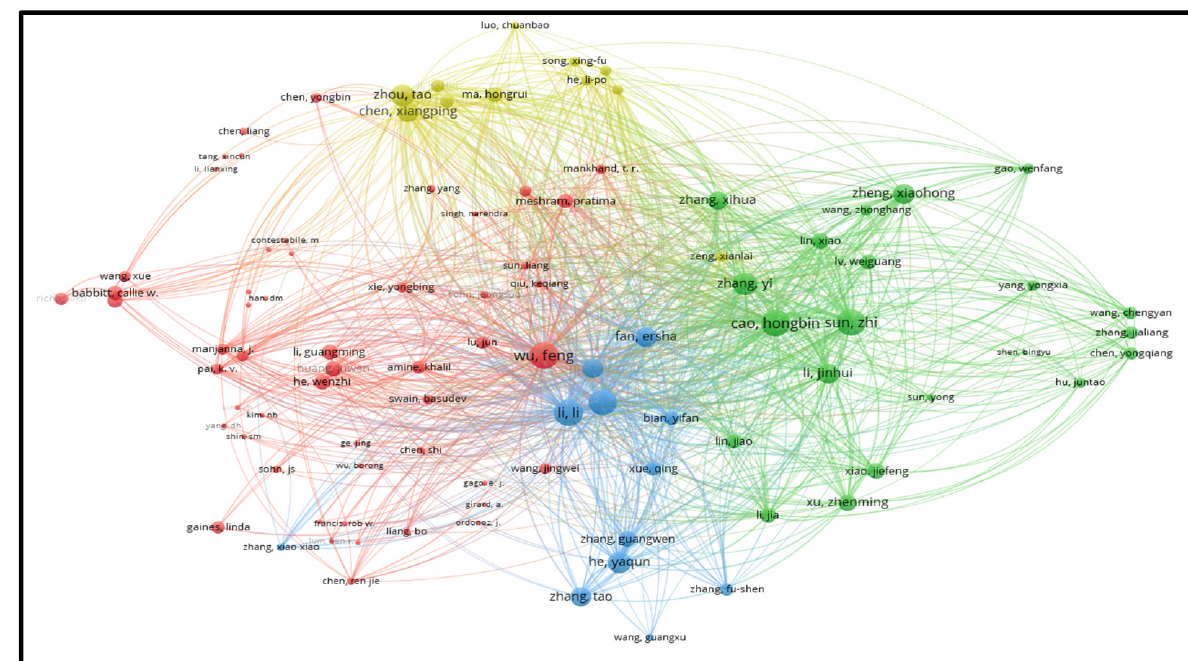
Figure 14. VOS Viewer Network Visualization of the 100 most cited authors.